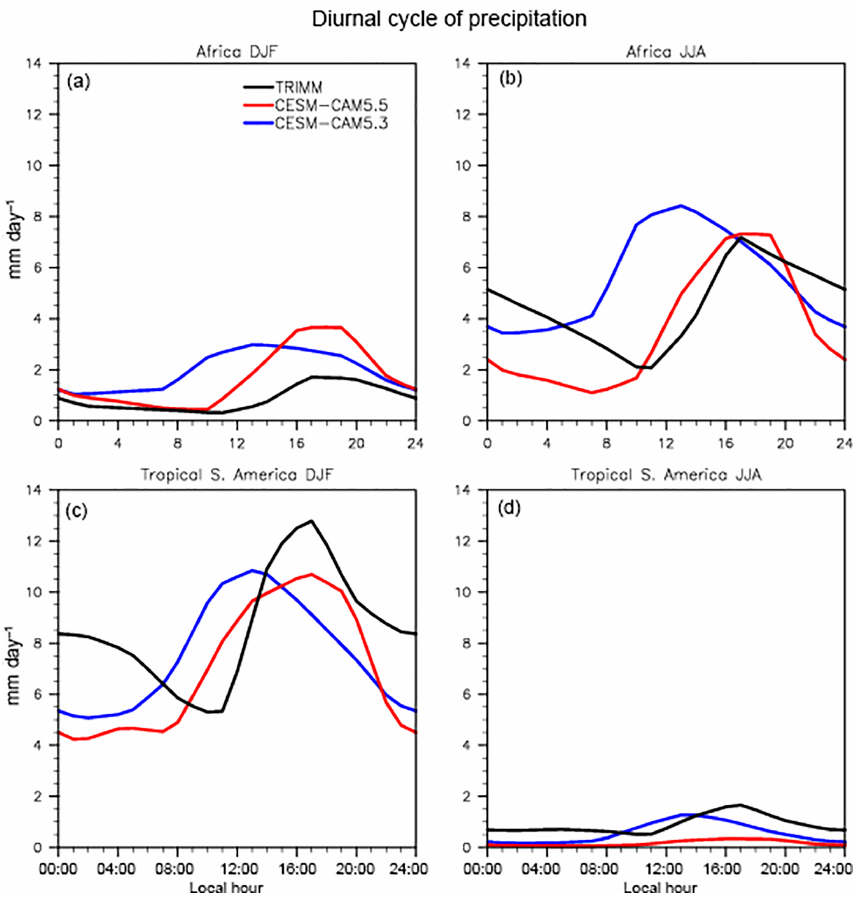
Figure 7. Timing composites of the diurnal cycle of precipitation for TRMM observations (black curves), CESM-CAM5.3 (blue curves), and CESM-CAM5.5 (red curves) for DJF ( a and c ) and JJA ( b and d ). The top row denotes the composites for an area average over tropical Africa (20 to 30 ◦ E and 0 to 10 ◦ N), while the bottom row denotes the composites for an area average over tropical South America (65 to 80 ◦ W and 20 to 5 ◦